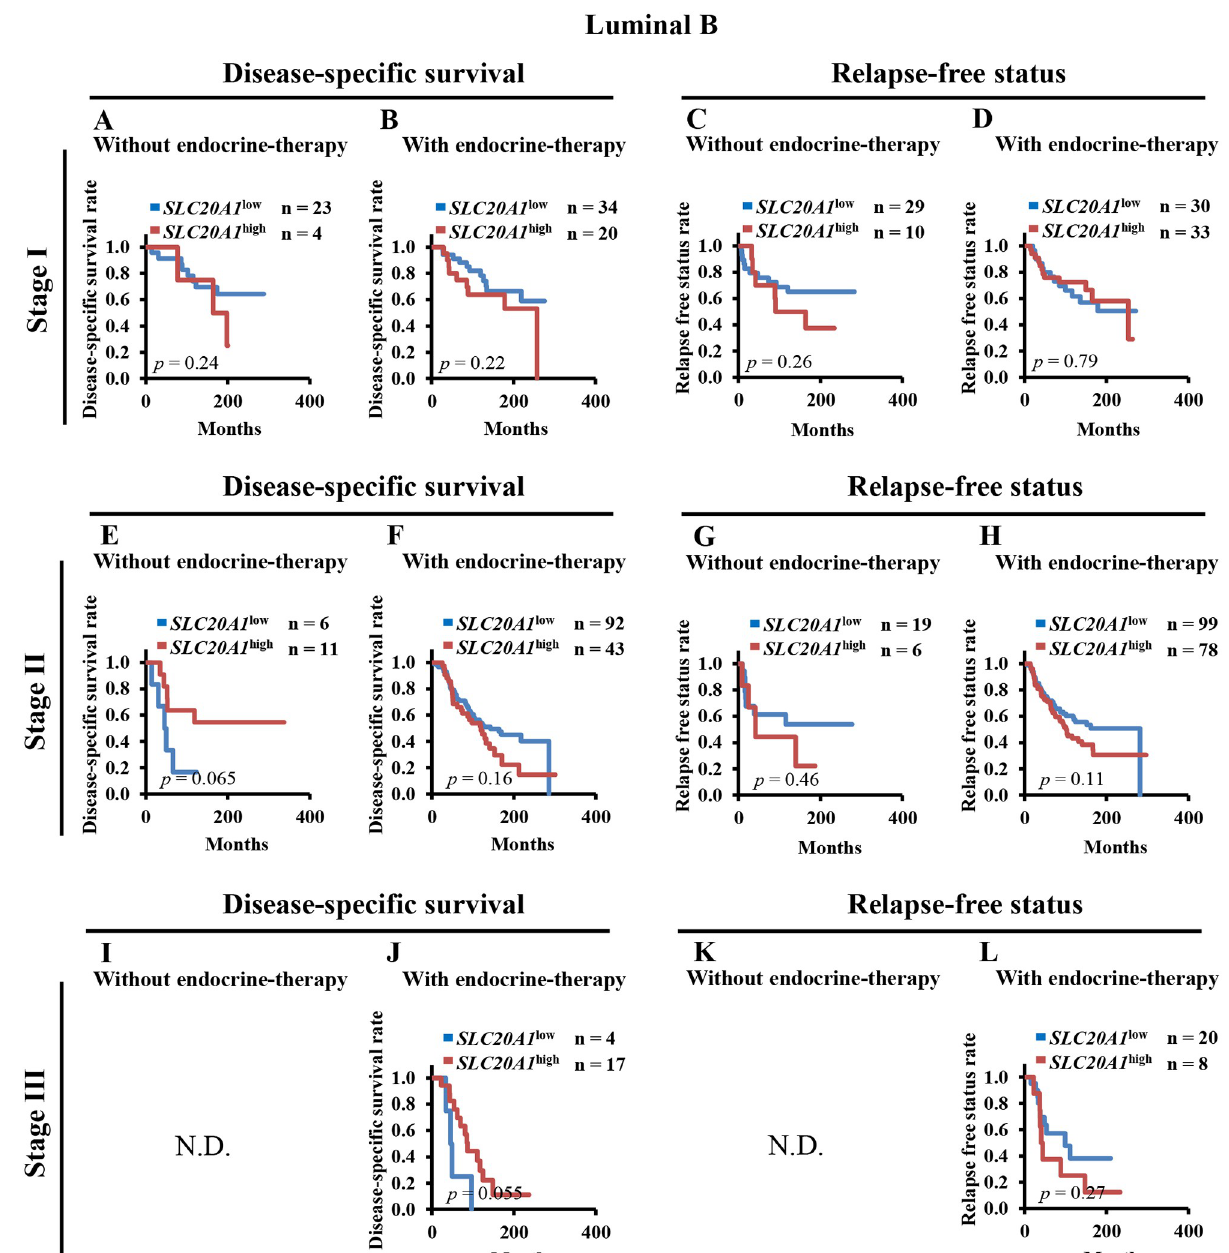
Fig 5. There are no significant differences between high solute carrier family 20 member 1 (SLC20A1) expression ( SLC20A1 high ) and low SLC20A1 expression ( SLC20A1 low ) in patients with luminal B breast cancer at each tumor stage undergoing endocrine therapy. (A-D) Kaplan- Meier analyses comparing disease-specific survival (DSS) or relapse-free status (RFS) between the SLC20A1 high and SLC20A1 low groups amongst patients with stage I luminal B breast cancer without or with endocrine therapy. (A) Comparing DSS of patients without endocrine therapy. (B) Comparing DSS of patients with endocrine therapy. (C) Comparing RFS of patients without endocrine therapy. (D) Comparing RFS of patients with endocrine therapy. (E-H) Kaplan-Meier analyses comparing DSS or RFS between the SLC20A1 high and SLC20A1 low groups amongst patients with stage II luminal B breast cancer without or with endocrine therapy. (E) Comparing DSS of patients without endocrine therapy. (F) Comparing DSS of patients with endocrine therapy, (G) Comparing RFS of patients without endocrine therapy. (H) Comparing RFS of patients with endocrine therapy. (I-L) Kaplan-Meier analyses comparing DSS or RFS between the SLC20A1 high and SLC20A1 low groups amongst patients with stage III luminal B breast cancer without or with endocrine therapy. (I) Comparing DSS of patients without endocrine therapy, (J) Comparing DSS of patients with endocrine therapy, (K) Comparing RFS at patients without endocrine therapy, (L) Comparing RFS of patients with endocrine therapy. (I and K) There were insufficient numbers for Kaplan-Meier analysis. N.D. stands for “not determined”.